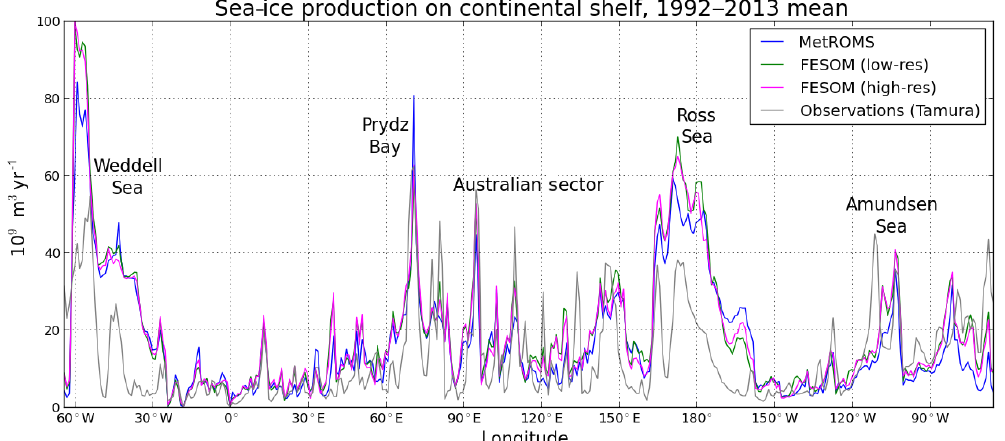
Figure 8. Sea-ice production (10 9 m 3 yr − 1 ) on the continental shelf (defined as regions south of 60 ◦ S with bathymetry shallower than 1500m), integrated over 1 ◦ longitude bins. Results are shown for MetROMS, low-resolution FESOM, high-resolution FESOM, and the observation-based estimate of Tamura et al. (2016) which uses ERA-Interim heat fluxes for its